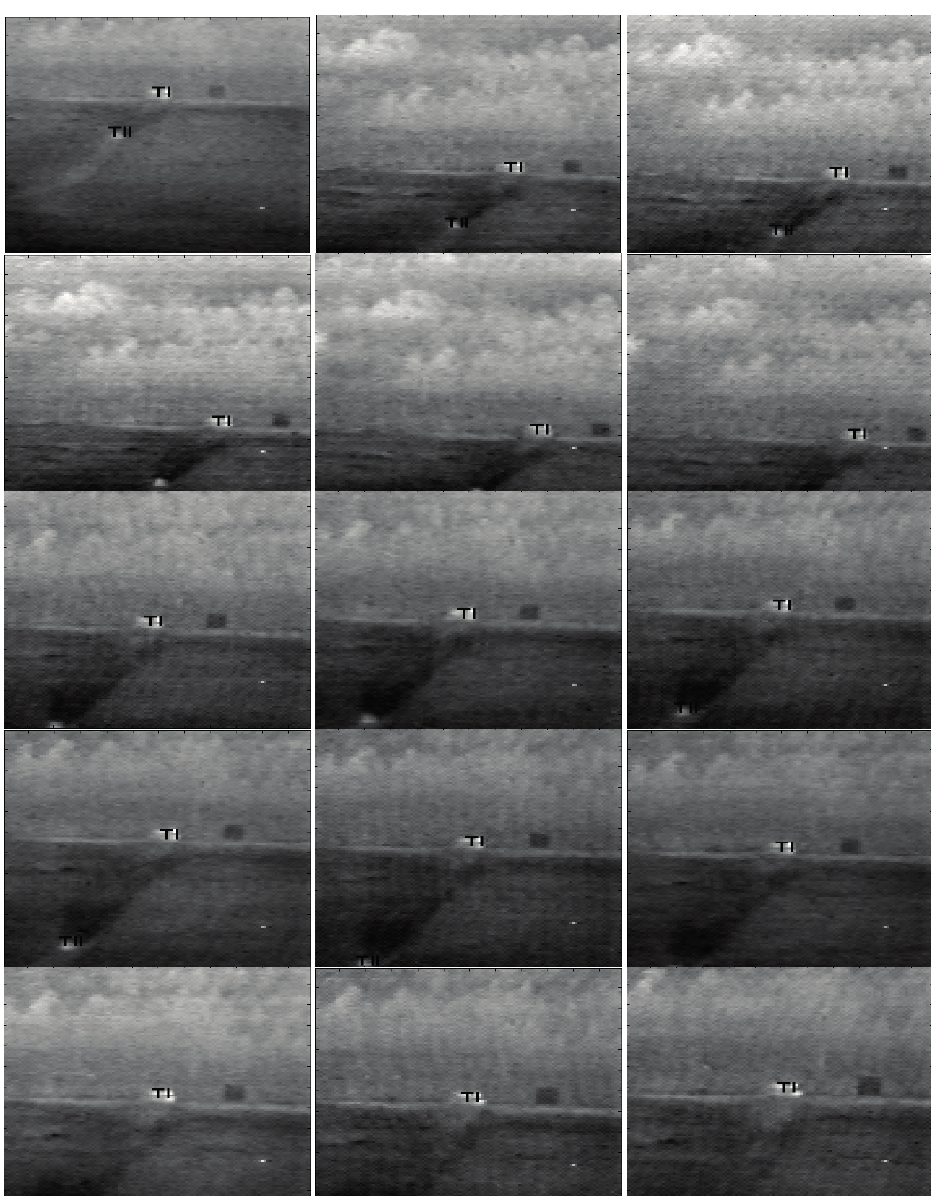
Figure 10. Target detection and classification results of Sequence